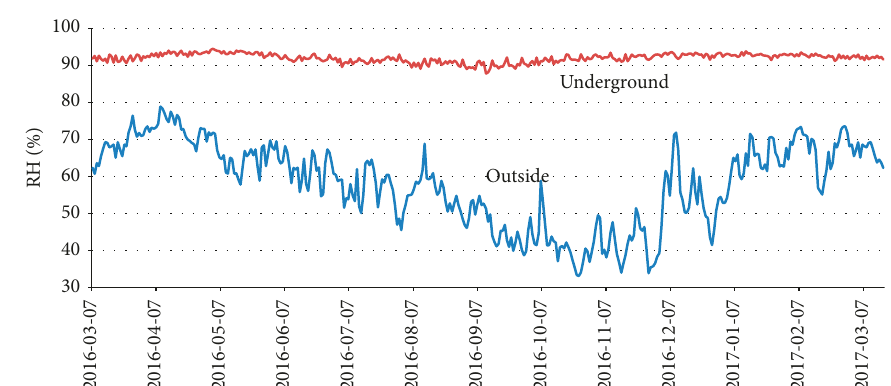
Figure 6: Humidity variation: inside the mine (logger #2) and outside.